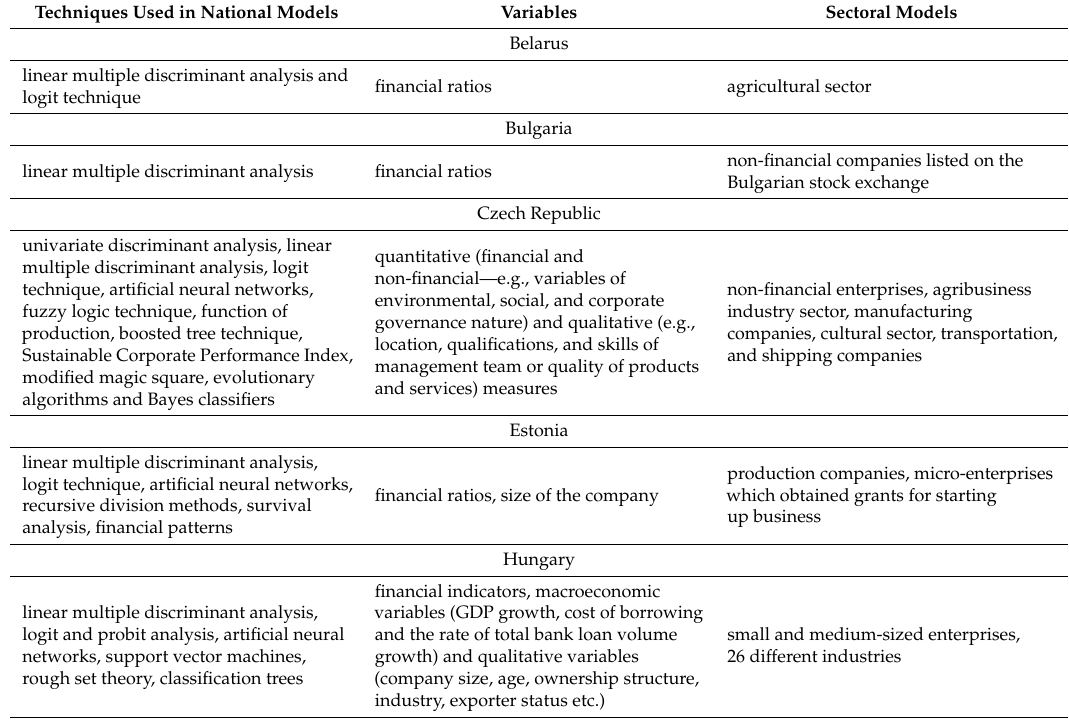
Table 1. Summary of research on forecasting enterprise bankruptcy in Central and Eastern